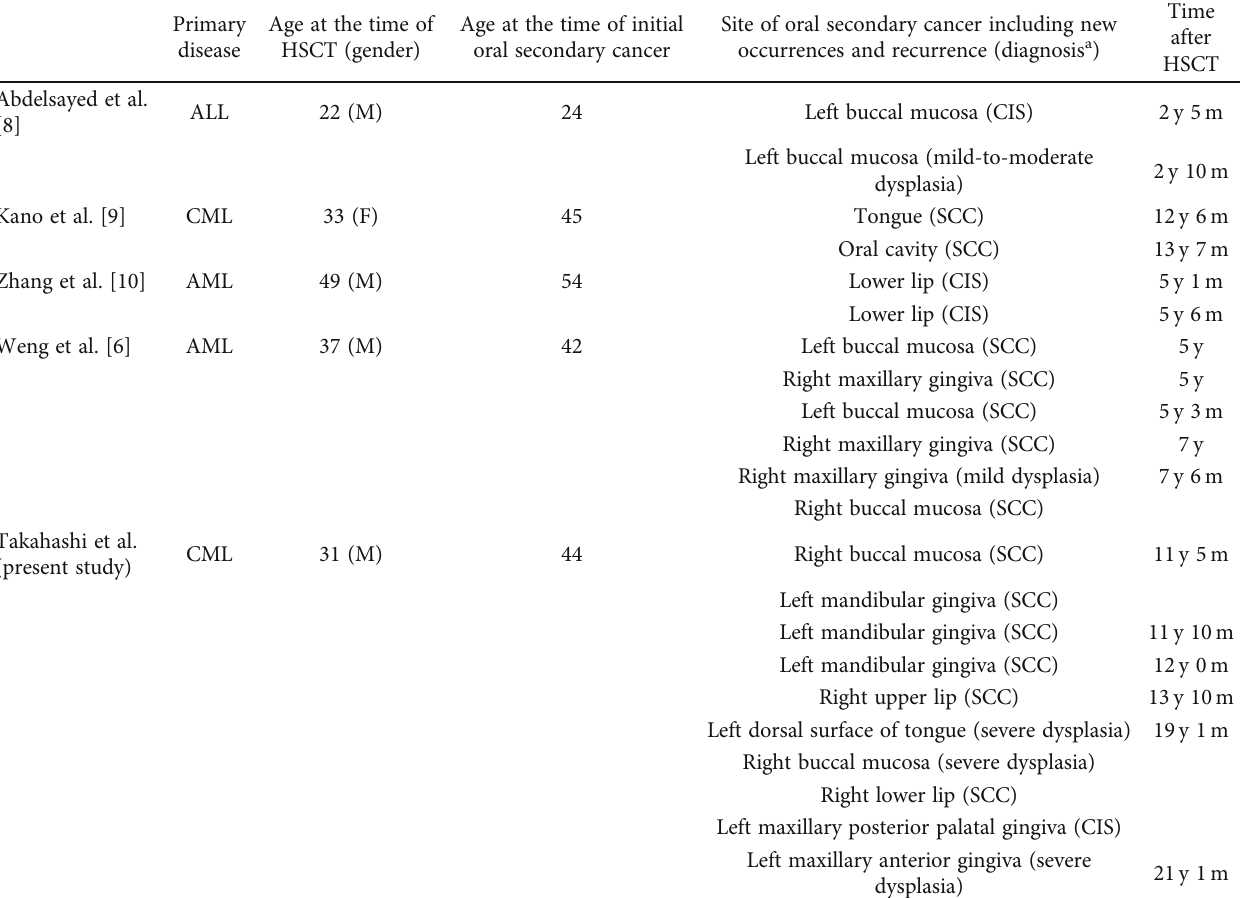
Table 1: Cases of multifocal and recurrence of secondary oral solid cancers after hematopoietic stem cell transplantation. Primary